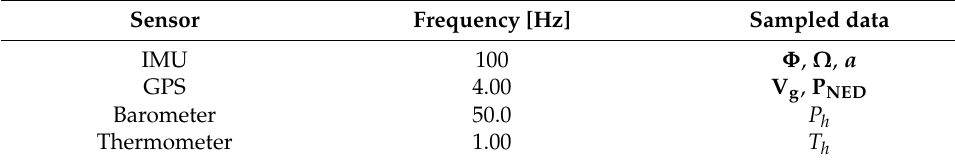
Table 1. Sample frequency specification.